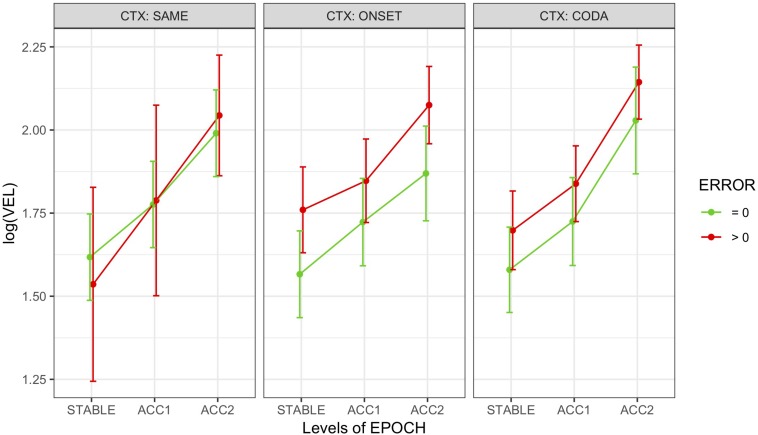
Marginal means by condition for epoch-based head peak velocity (VEL) grouped over speakers and distinguishing error-free trials from those with at least one error. Error bars show SEM.